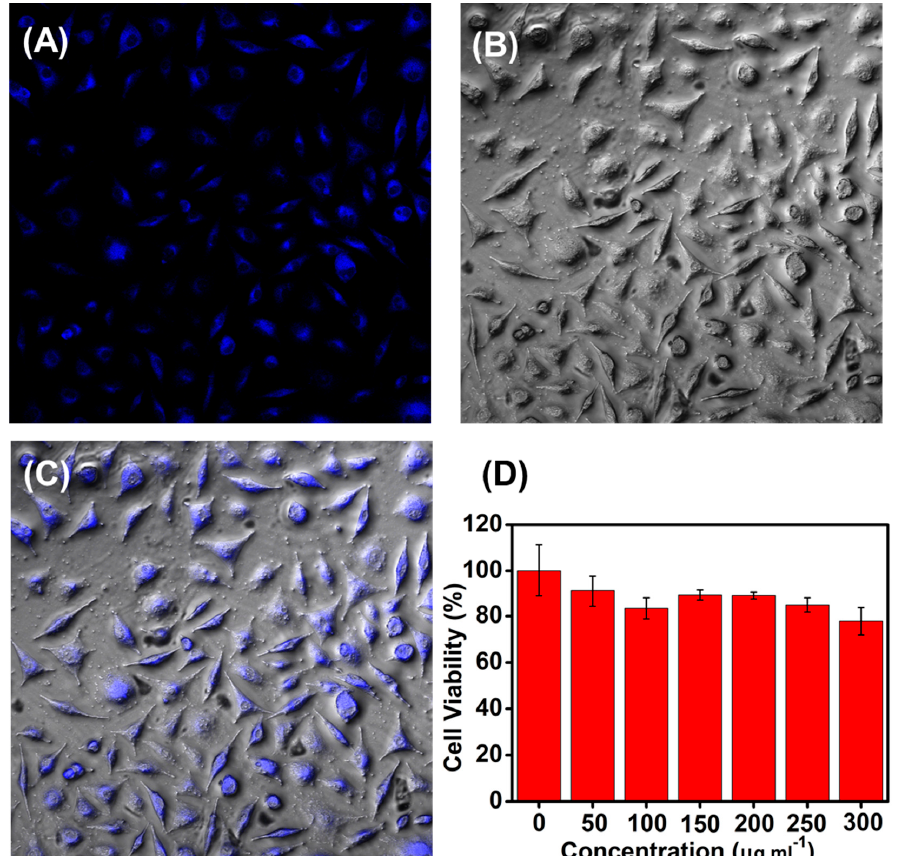
Figure 4. LSCM images of bamboo fiber cells from incubated with MoS 2 QDs of 60 μ g mL − 1 for 4 h at 37 °C. ( A ) PL images and ( B ) bright field images; Excitation wavelength was set at 365 nm; ( C ) overlay of (A) and (B). ( D ) MTT assay of the bamboo fiber cells after being treated with of MoS 2 QDs at various concentrations of 0, 50, 100, 150, 200, 250, and 300 μ g mL − 1 , respectively. The viability of the cells without MoS 2 QDs incubation were set as the control (100%).